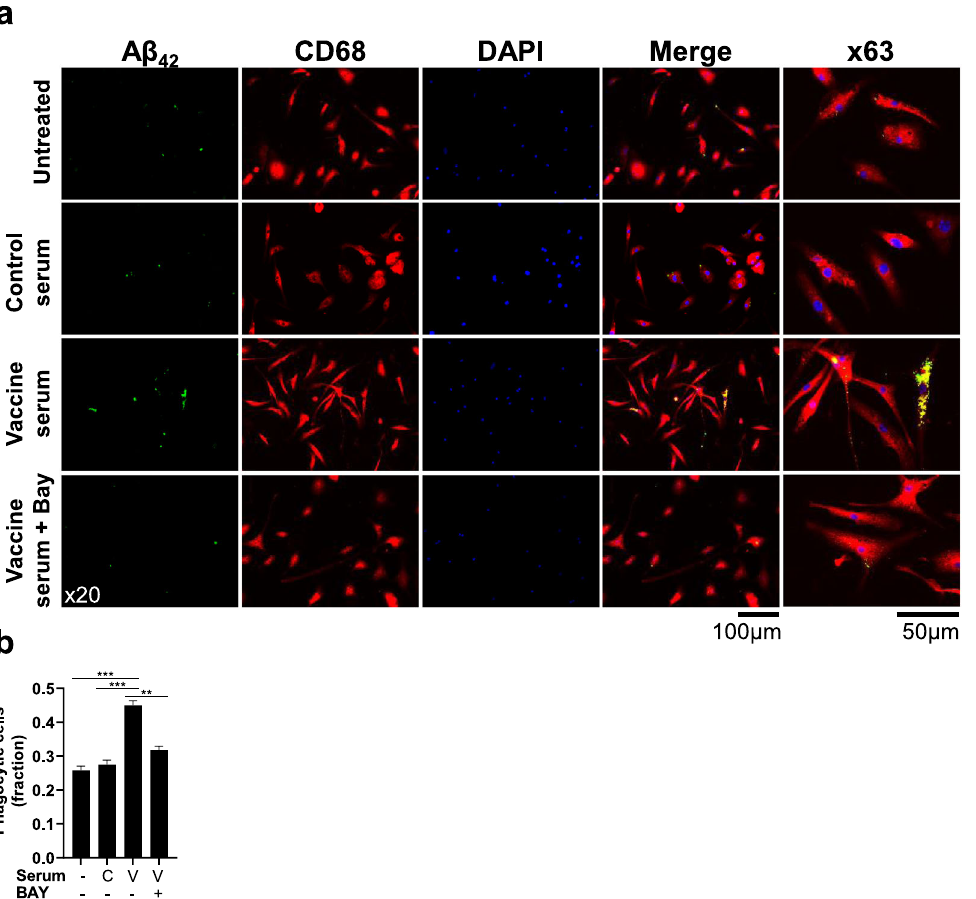
Fig. 10 Maternal antibodies mediate A β phagocytosis by primary adult microglia in a Syk-dependent manner. A β phagocytosis capacity of adult primary microglia was assessed following treatment with either A β 42 alone or A β 42 pre-incubated with serum from anti-A β or sham-vaccinated dams. The contribution of Syk signaling was assessed using Syk inhibition by BAY-61-3606. a Immuno fl uorescence images and ( b ) quanti fi cation of A β phagocytosis by adult primary microglia reveal that serum from anti-A β vaccinated dams facilitates A β clearance in a Syk-dependent pathway. ** P < 0.01, *** P < 0.001, Chi-squared test for independence, Fisher ’ s exact test, data are presented as mean ±